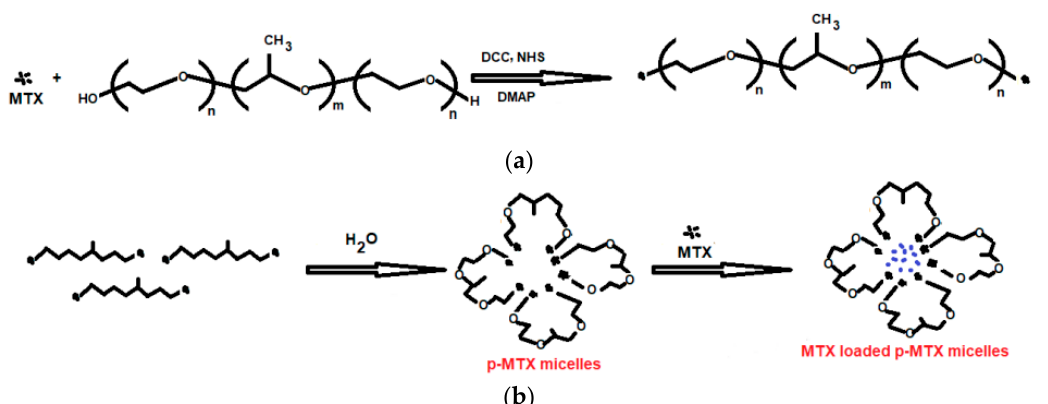
Figure 2. Synthetic Route of ( a ): p-MTX conjugates and ( b ): the formation of p-MTX micelles and MTX ‐ loaded p–MTX micelles [40].